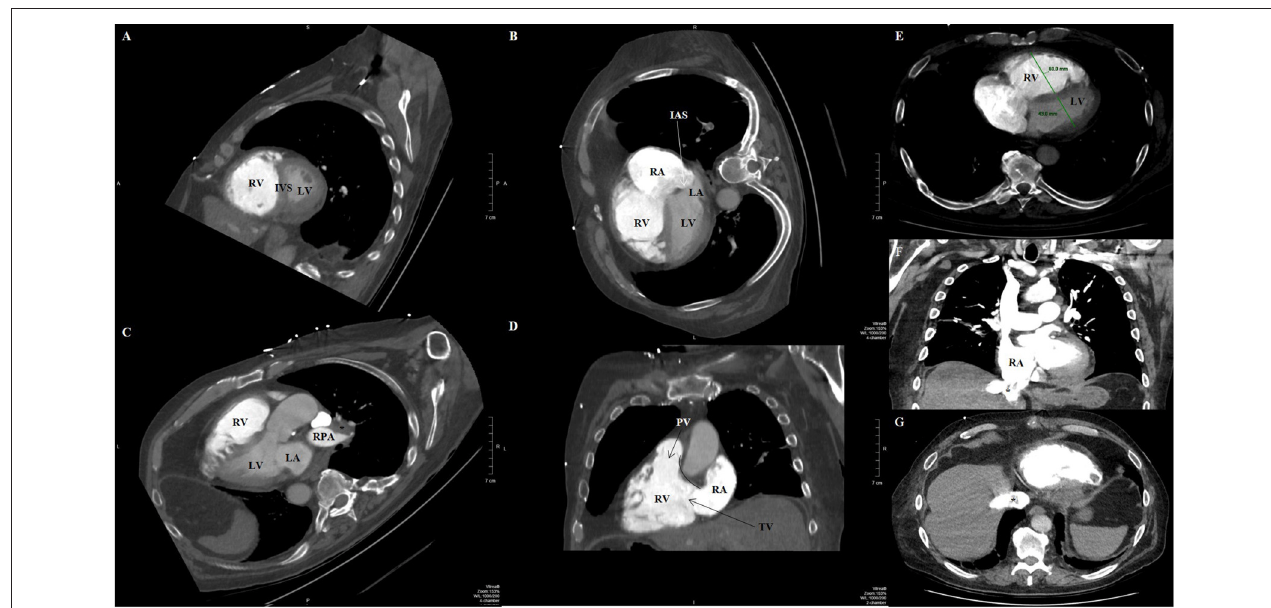
FIGURE 8 | Contrast-enhanced computed tomography timed for the right heart and pulmonary artery circulation of a patient with pulmonary hypertension and pulmonary embolism, reformatted into cardiac views (A–D) . (A) Short-axis view at the level of the ventricles reveals right ventricular dilation and interventricular septal flattening and bowing toward the left ventricle. (B) Four-chamber view showing both right ventricular and right atrial dilatation, and bowing of the interatrial septum. (C) Three-chamber view showing again enlarged right ventricle, as well as filling defect (asterisk) compatible with pulmonary embolism in the right pulmonary artery. (D) Two-chamber view dedicated to the right heart showing the right ventricular inflow and outflow, where the tricuspid and pulmonic valves can be seen, including the discontinuity between the atrioventricular (tricuspid) and semilunar (pulmonic) valves that characterizes the morphologic right ventricle. (E) Transaxial view showing increased RV:LV diameter ratio (1.4). Coronal (F) and transaxial (G) views showing contrast reflux (asterisks) into the inferior vena cava and hepatic venous system compatible with significant tricuspid regurgitation. IAS, interatrial septum; IVS, interventricular septum; LA, left atrium; LV, left ventricle; PV, pulmonic valve; RA, right atrium; RPA, right pulmonary artery; RV, right ventricle; TV, tricuspid